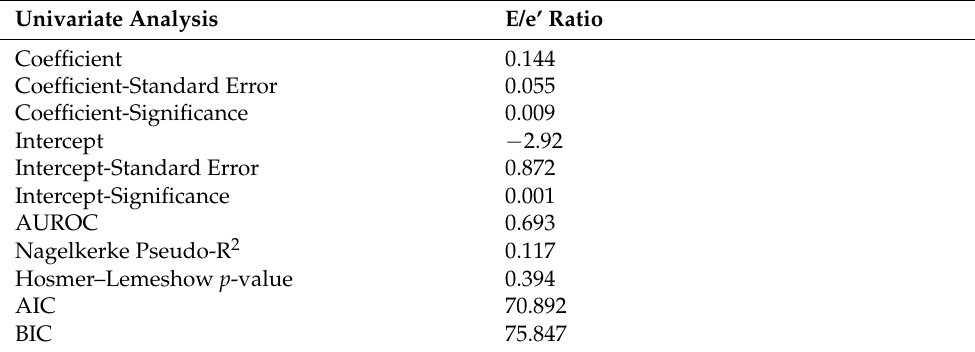
Table A2. Univariate Analysis for E/e’ ratio according to rehospitalization for a first episode of acute HFpEF within the first 6 months after the first